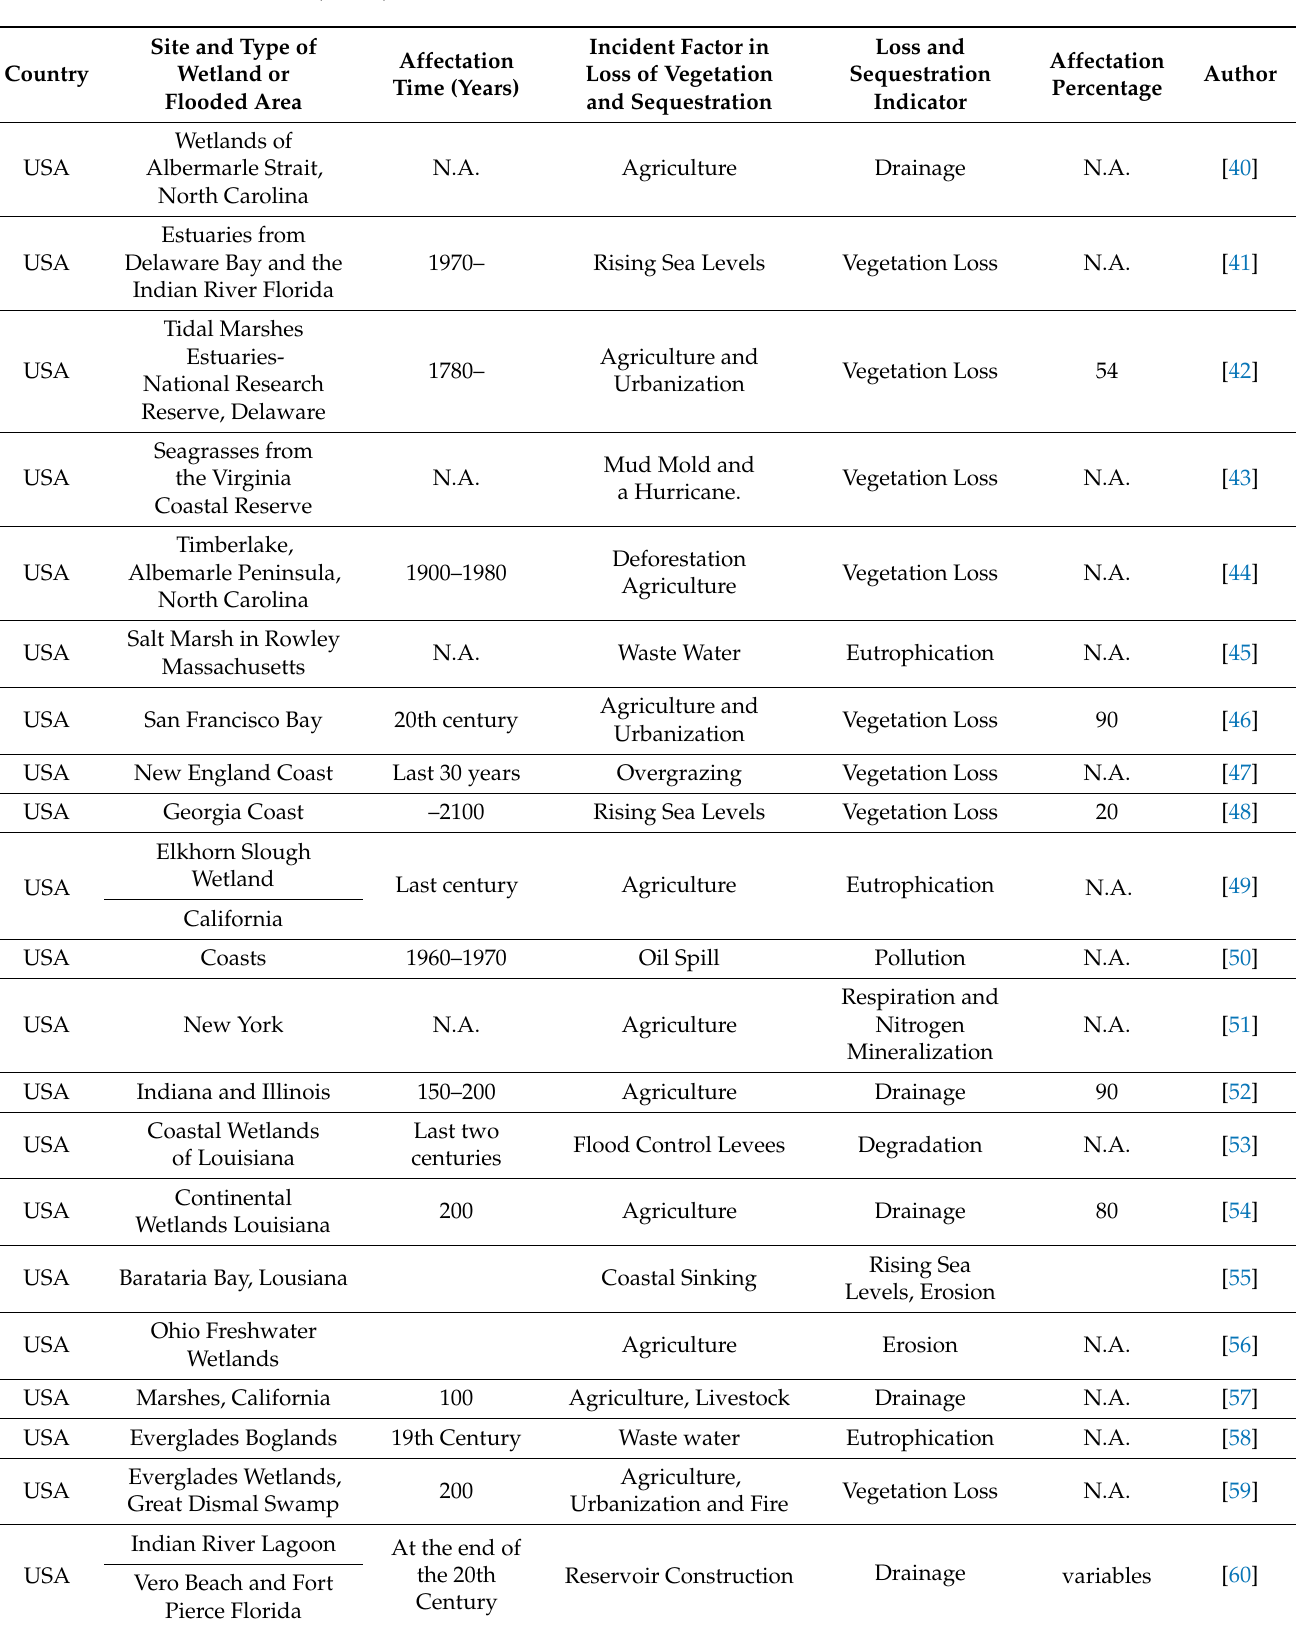
Table 2. Data from the American continent on wetlands in coastal, marine, and continental zones (n =